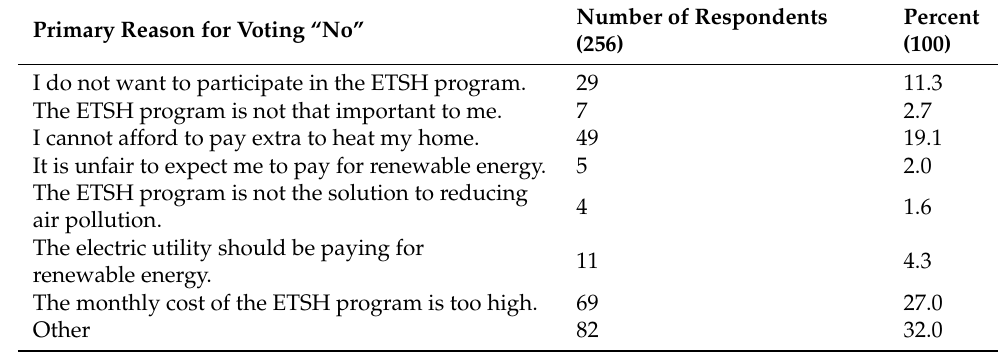
Table 2. Responses to Survey Question 24: Please indicate your primary reason for voting “No”.